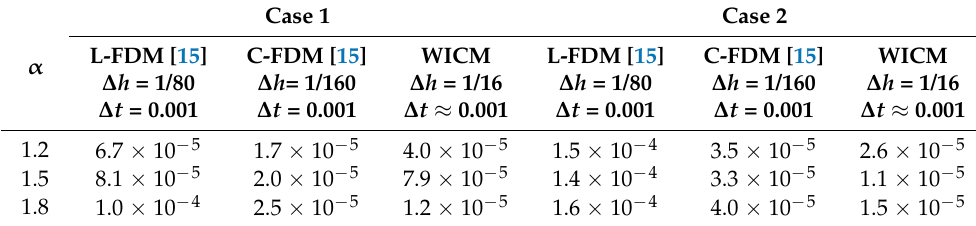
Table 4. Error norms of numerical solutions with similar time step for Example 4 with different α .